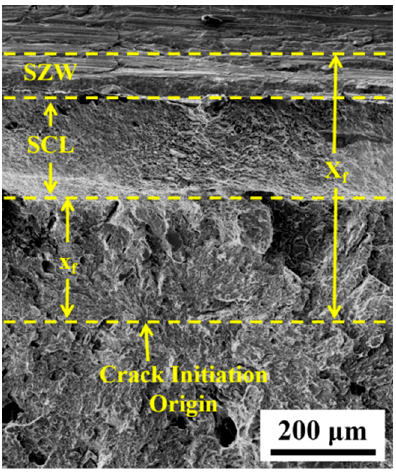
Figure 6. Macro-fracture surface showing the integrating measurements of stretch zone width (SZW), fibrous crack length (SCL), and the x f from PWHT specimen.